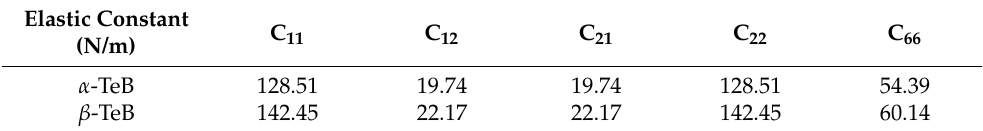
Table 2. The calculated elastic constant of the α -TeB and β -TeB monolayers. Elastic